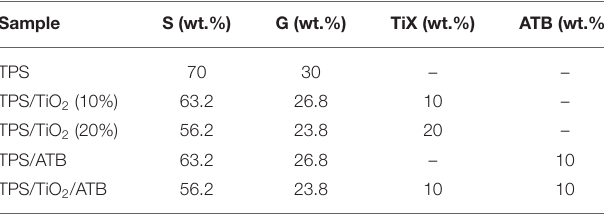
TABLE 1 | List of the prepared TPS-based composites.